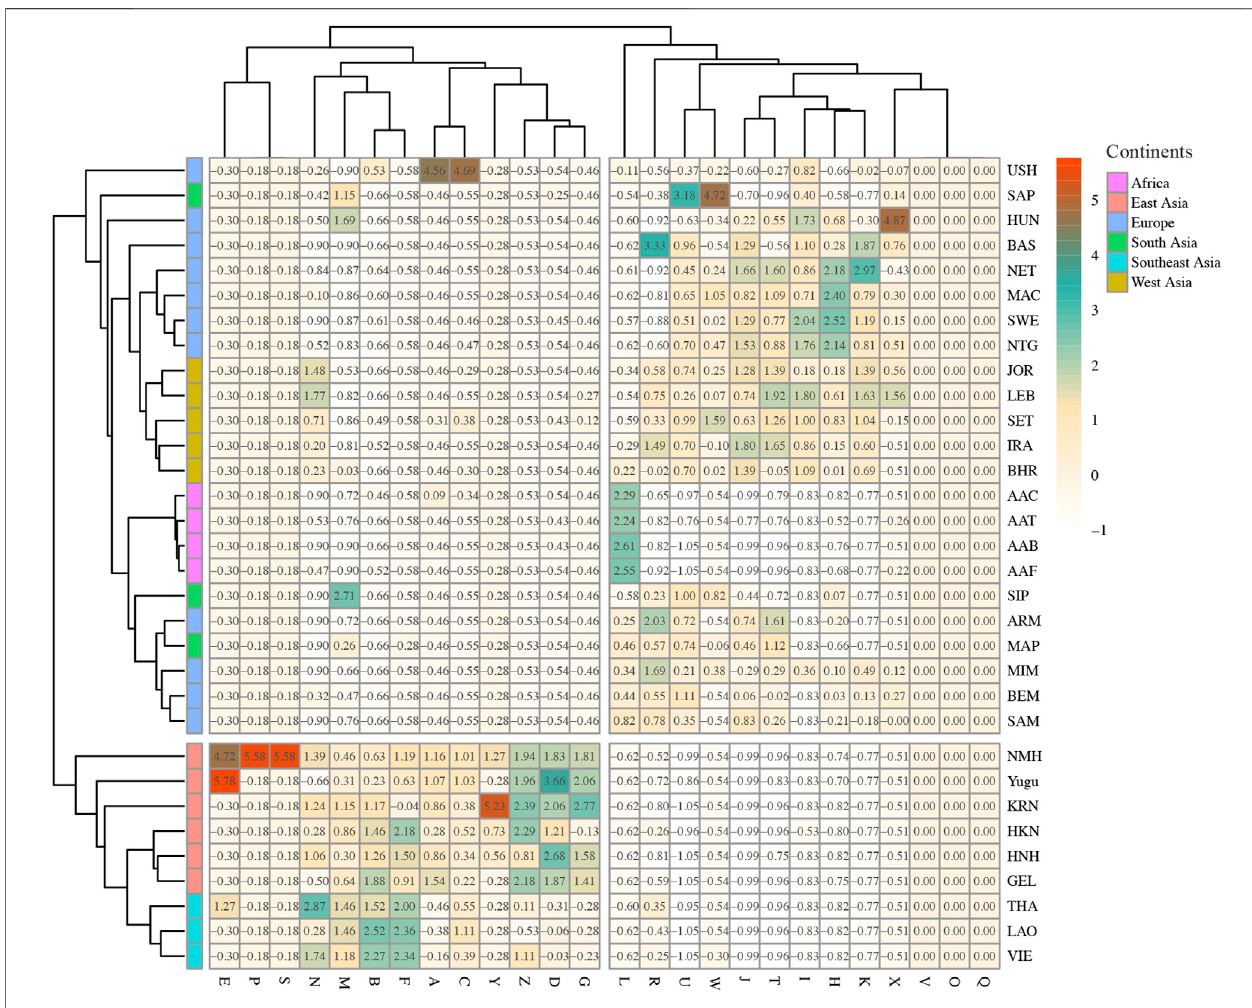
FIGURE7| MtDNAhaplogroupfrequencies ofthetwostudied populationsand thereferencepopulations. Thefrequenciesofhaplogroupsare represented bythe color gradient. The color gradient for mtDNA haplogroup frequencies ranges from white to red, corresponding to the mtDNA haplogroup frequencies from low to high.